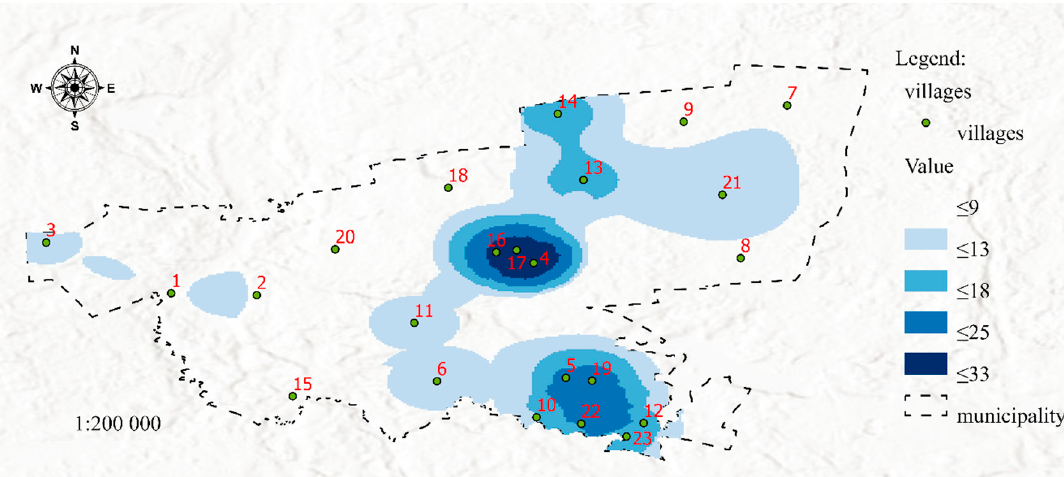
Figure 4. Map 2-Visualization of the future risk of poverty (dataset 2). Source: Own elaboration.